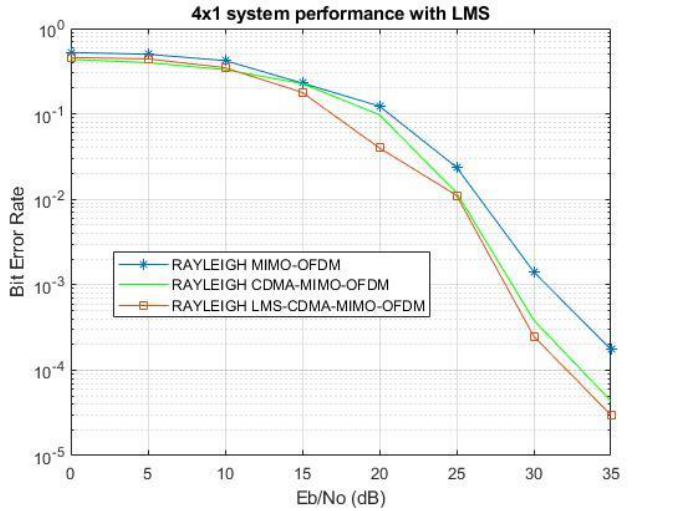
Figure 15. SNR vs. BER plot for 4×1 LMS-MIMO-OFDM model in Rayleigh channel.